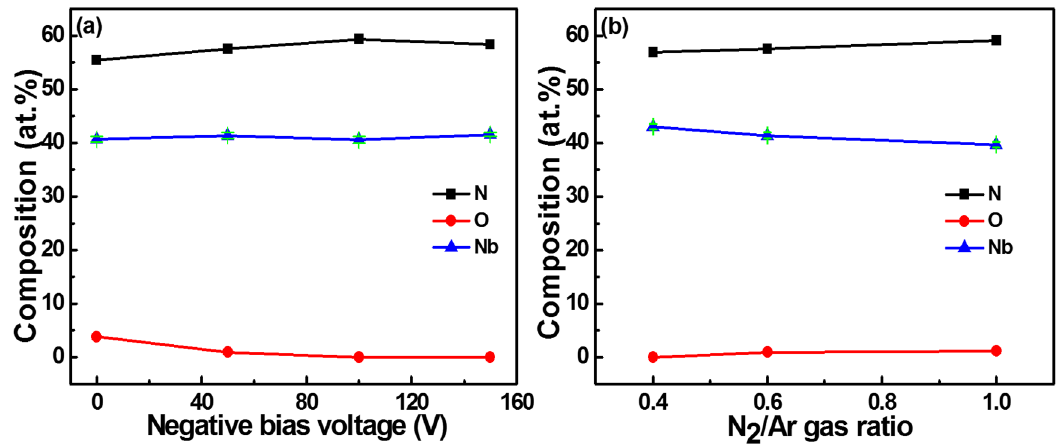
Figure 1. Elemental compositions of NbN coatings deposited under different bias voltages with constant 0.6 ratio of N 2 /Ar ( a ); and under different N 2 /Ar gas ratios with constant − 50 V bias voltage ( b ).